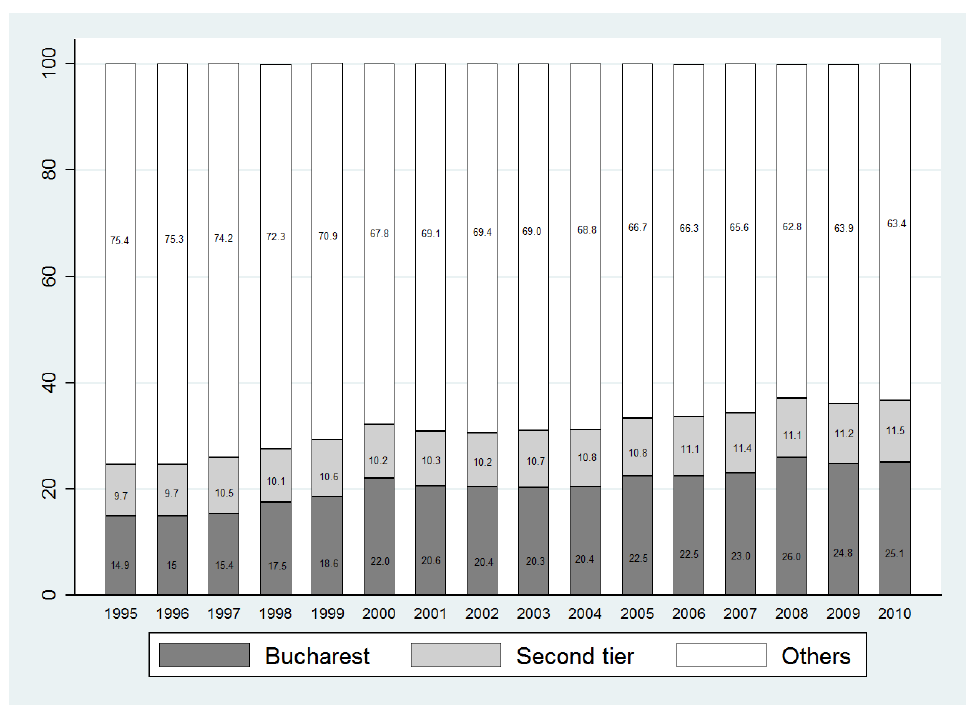
Figure 2: Share of national GDP by different typologies of NUTS3